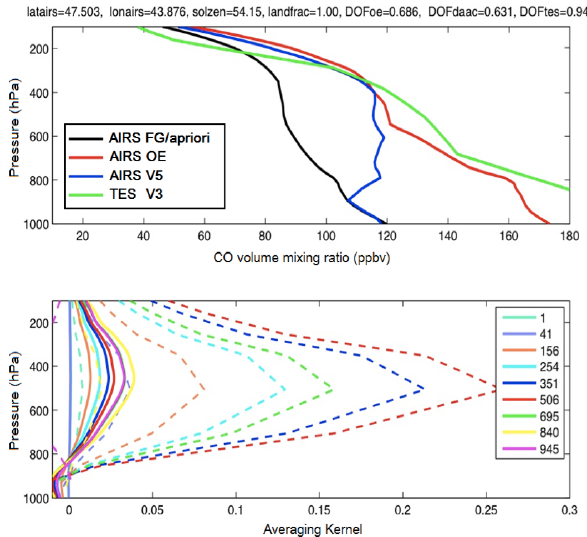
Figure 4. Fig. 4. A typical NH CO profile comparison from the retrievals on 4 March 2006, where the black curve on the top panel represents the first guess for V5 and the mean OE a priori profile. The dark blue curve on the top panel represents the 9-level AIRS V5 CO from NASA/DAAC, the red curve represents the AIRS OE CO, and the green line shows the collocated TES CO profile. The bottom panel shows the AKs from the V5 retrievals (dashed) and from the OE (solid) at pressure levels (hPa) identified by the legend.